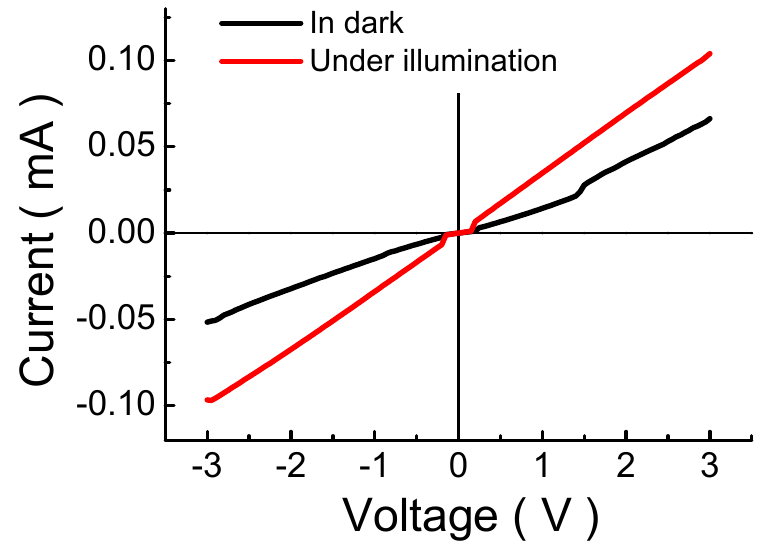
Figure 1. Current-voltage (I-V) curves of MP1D film in dark and under illumination. To investigate the reflectance of MP1D film, it was spin-coated on an ITO-coated glass (i.e., an MP1D-coated sample). Figure 2 depicts the reflectance spectra of the MP1D film. The reflectance of an MP1D-coated sample is small in comparison with that of the ITO-coated glass (i.e., an uncoated sample) in a wavelength range of 400–800 nm, as presented in Figure 2. It obviously demonstrates that MP1D film has AR characteristics. Moreover, the reflectance of an MP1D-coated sample slightly decreases with wavelength. This is because the step gradient refractive-index distribution is in multiple films. In the case of a single-layered AR film, a single coating is deposited on the device surface, so that light reflections from the air/AR film and AR film/device surface interfaces undergo interference. To eliminate reflection, this interference has to be a destructive interference. As a consequence, the thickness of a single-layered AR film must be odd-multiples of the quarter wavelength in the coating and thus depends on the wavelength. Moreover, the refractive index of a single-layer AR film equals the square root of the refractive index of the device surface. MP1D film thickness is around 77 nm and is not optimized in Figure 2. Hence, the reflectance is not greatly